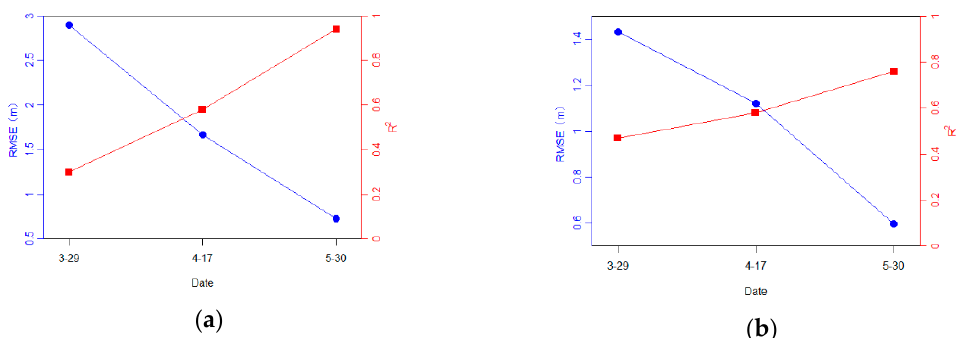
Figure 8. Tree height estimated RMSE and R 2 values of TM ( a ) and FV ( b ) on all three dates. The blue dots and lines are for the RMSEs, while the red dots and lines are for the R 2 values.